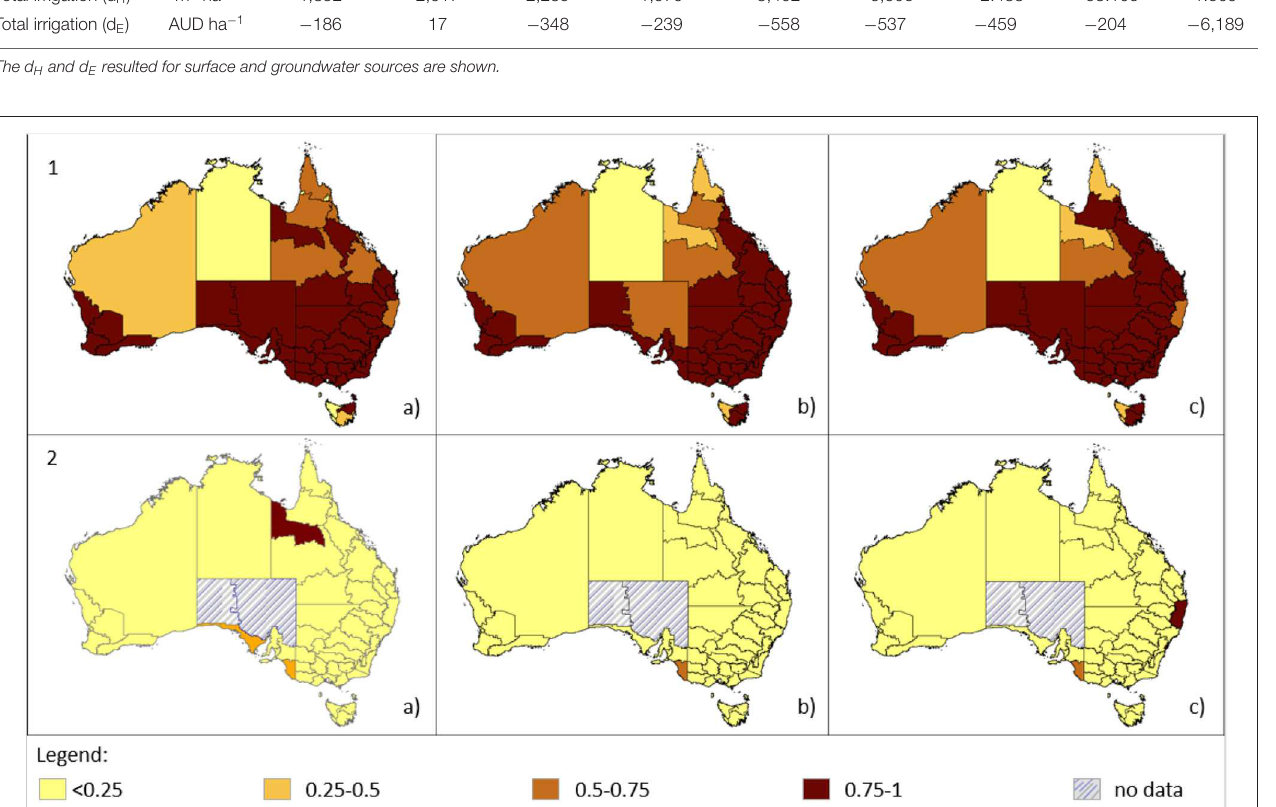
Likewise, areas that are presently weakly sustainable